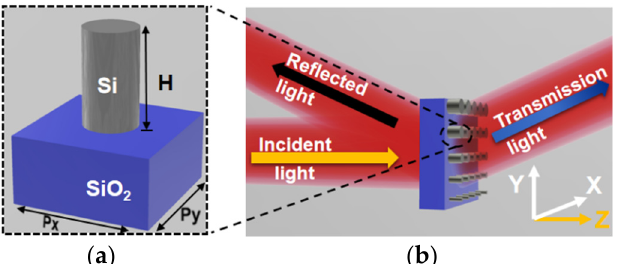
Figure 1. ( a ) The columnar unit cells of the parallel light-spli tt ing metasurface beam spli tt er. The materials of the nanocolumn and the substrate are Si and SiO 2 , the geometric parameters of the cell are period Px = Py = P = 1 µm, and the height of the nanocolumn is H = 3.2 µm. ( b ) The schematic of the parallel light-spli tt ing metasurface beam spli tt er, with blue arrows for transmi tt ed light, black for re fl ected light, and yellow for incoming light.